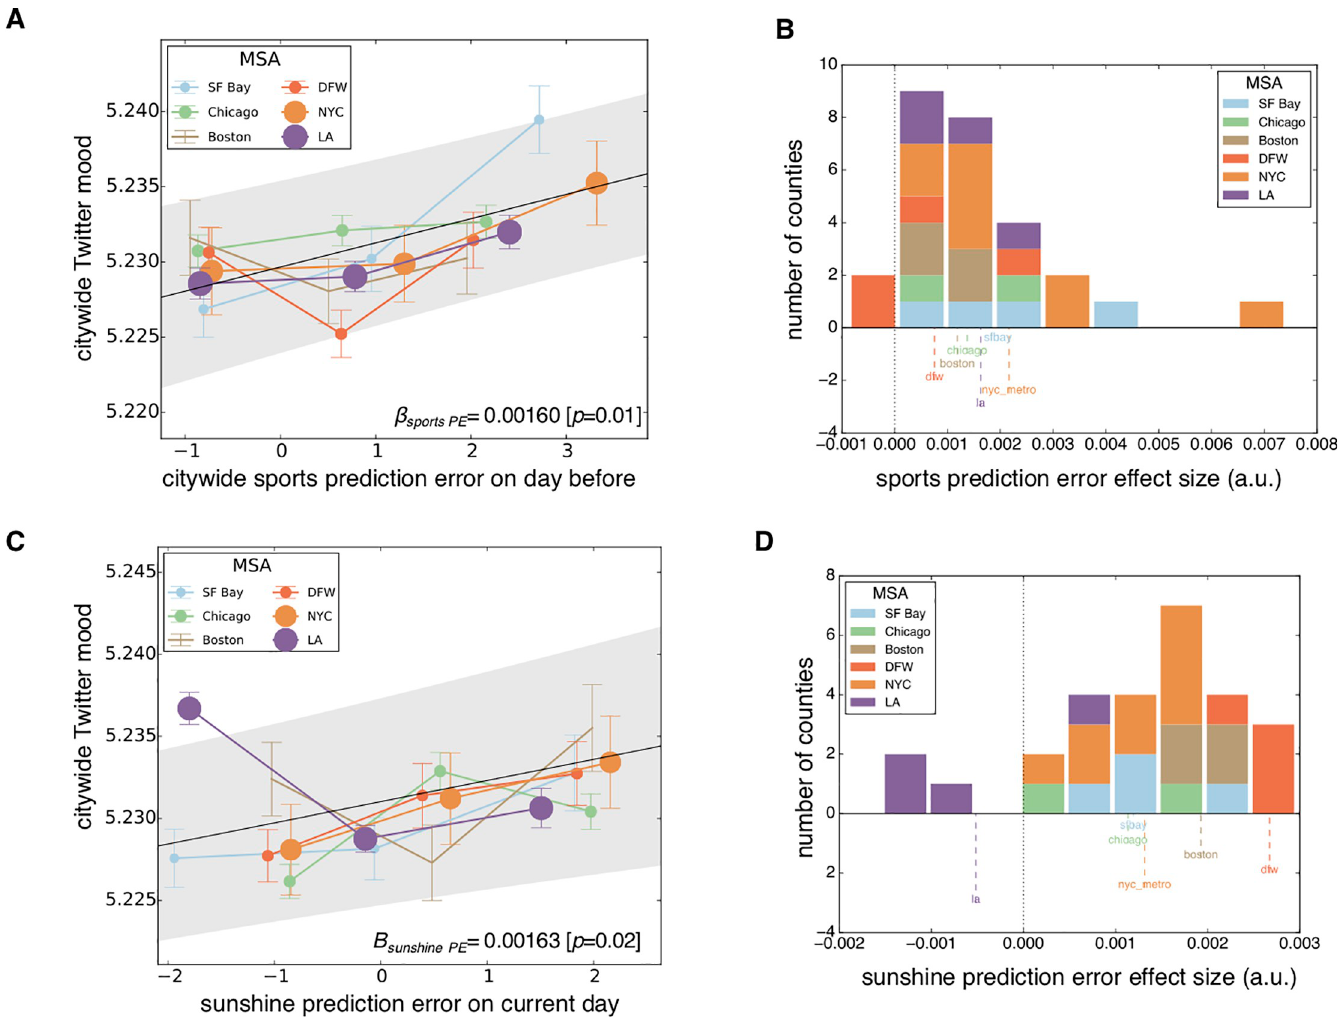
Fig 2. Sports prediction errors and Twitter-inferred mood. (A) When the aggregate of local sports teams performs better than expected on the previous day— engendering a positive citywide sports prediction error—Twitter-inferred citywide mood increases significantly. Residual Twitter-inferred mood is plotted for all Metropolitan Statistical Areas (MSAs), after controlling for a number of nuisance variables, along the vertical axis. The populations of each MSA included are represented by point size. The black solid line represents the regression line corresponding to the effect of sports prediction errors across all MSAs (shaded gray represents standard error) and the dashed line represents a zero-magnitude effect or baseline). (B) Histogram of effect sizes for citywide sports prediction errors for each of across the 27 counties examined (color indicates the MSA to which each county belongs). The county-level effect size distribution, obtained from this regression model, suggests that the positive effect of local sports prediction errors on subsequent county-level mood is nearly unanimous. (C) When sunshine levels are higher than expected based on recent history, Twitter-inferred citywide mood increases significantly on the present day. (D) The distribution of county-level sunshine prediction- error effects are generally positive with the apparent exception of counties in the Los Angeles MSA. All data plotted in this figure are from the confirmatory dataset (the year